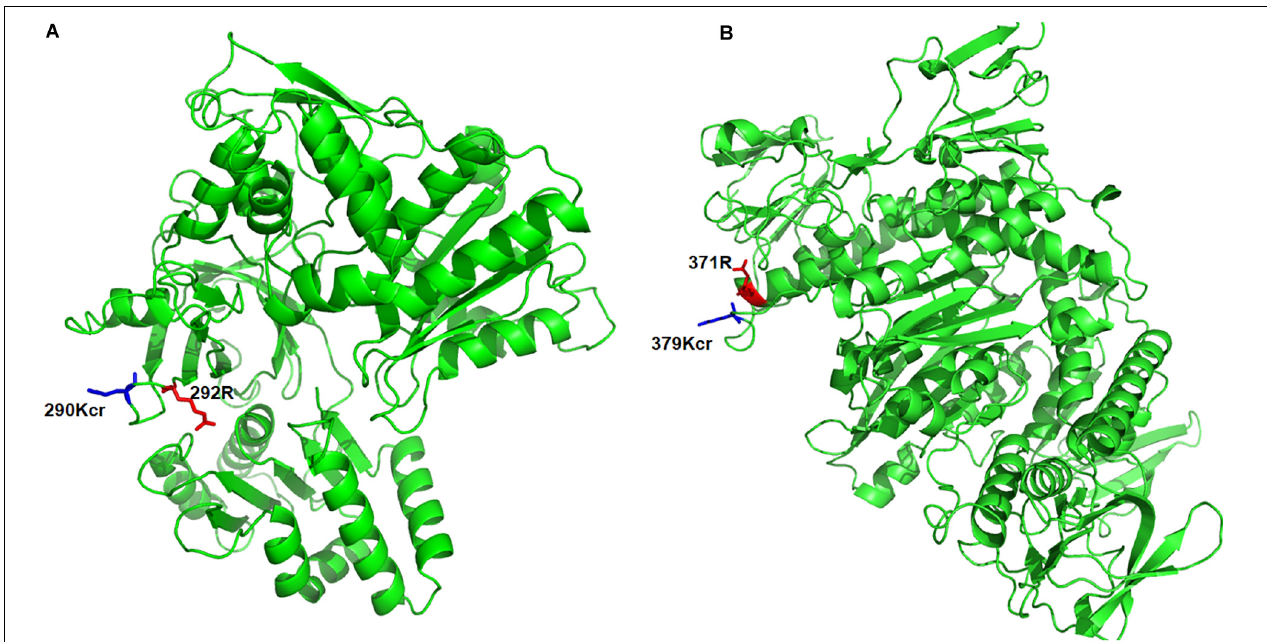
FIGURE 5 | Three-dimensional structure of Bccpr1 (A) and Bcglr1 (B) with identified crotonylation site. The structure was derived from PDB database. The crotonylated lysine residues and adjacent arginine residues were indicated by blue and red colored sticks,